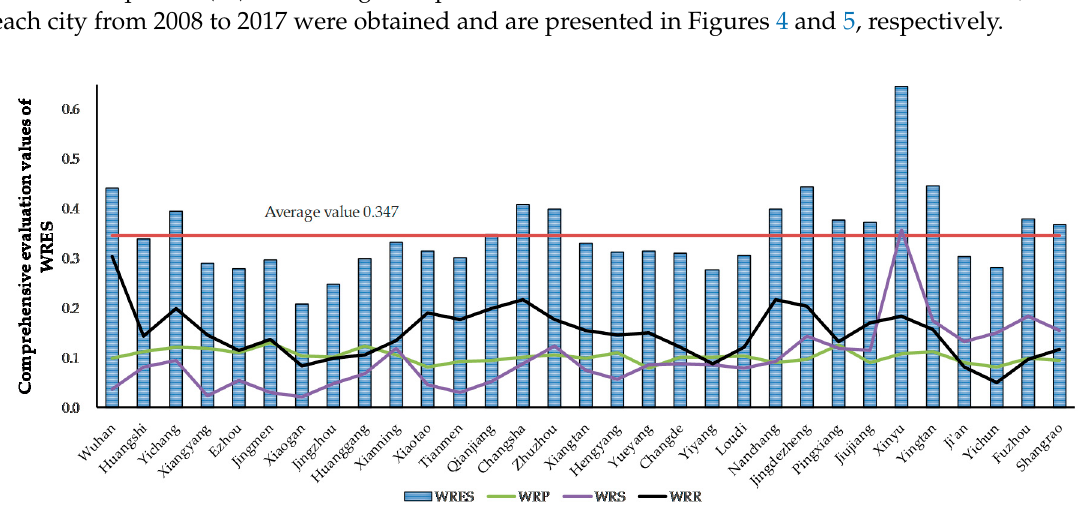
Figure 3. Location of the urban agglomeration in the middle reaches of the Yangtze River in China.